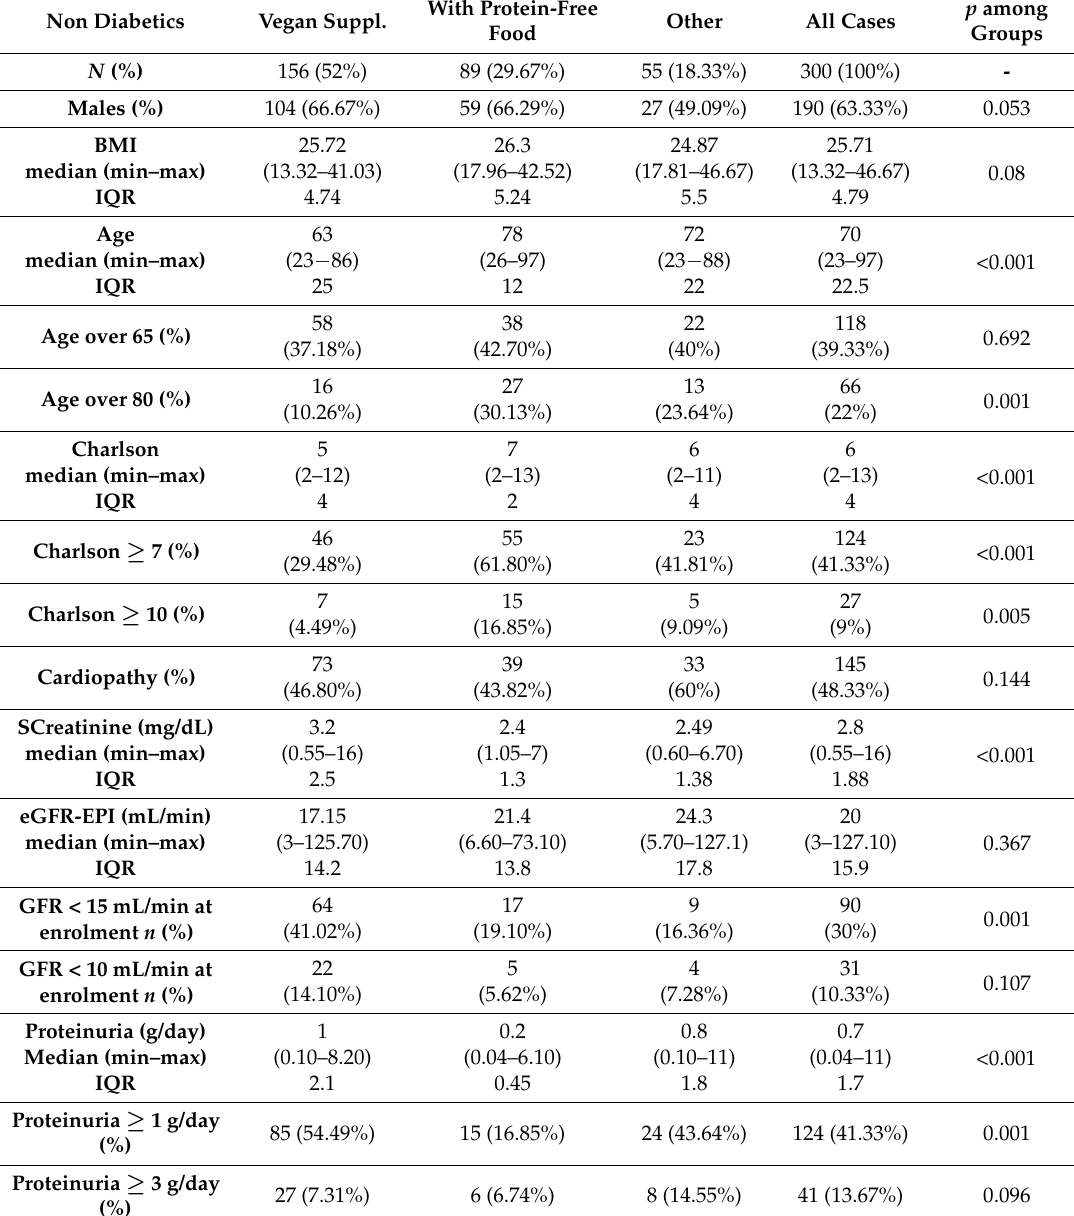
Table 4. Baseline characteristics of the non-diabetic CKD population, according to the diets